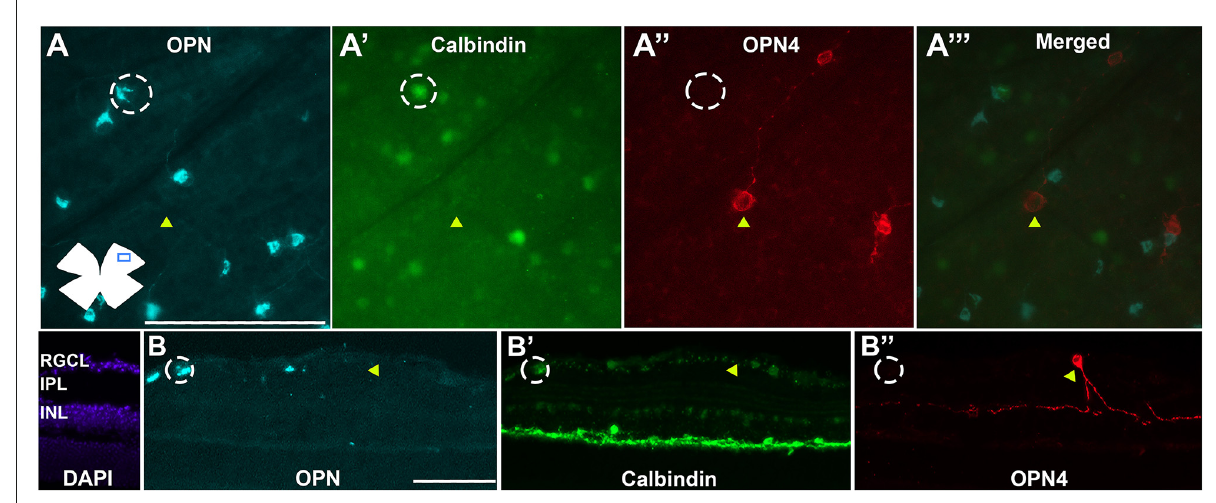
FIGURE6 ONs- α RGCs are not immunodetected against melanopsin. Photomicrographs of flat-mounted retinas (A–A (cid:48)(cid:48)(cid:48) ) or radial retinal sections (B–B (cid:48)(cid:48) ) immunodetected against the α RGC pan-marker OPN (A,B) in blue, Calbindin (A’,B’) in green and OPN4 (A”,B”) in red (merged in A (cid:48)(cid:48)(cid:48) ) in the same area of the retina. White circles represent cells positive for OPN + and Calbindin + but negative for OPN4 (ONs- α RGCs/M4ipRGCs) and yellow arrowheads represent cells positive for OPN4 but negative for OPN and Calbindin (M1-M3-ipRGCs). Scale bar: 100 µ m.